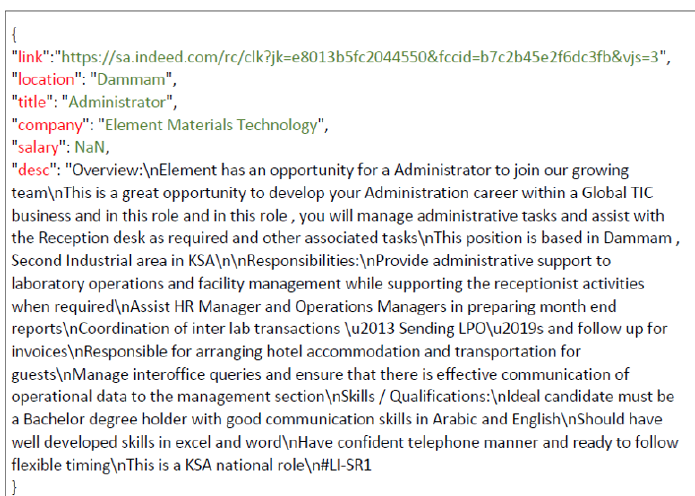
Figure 8. Job profiles data